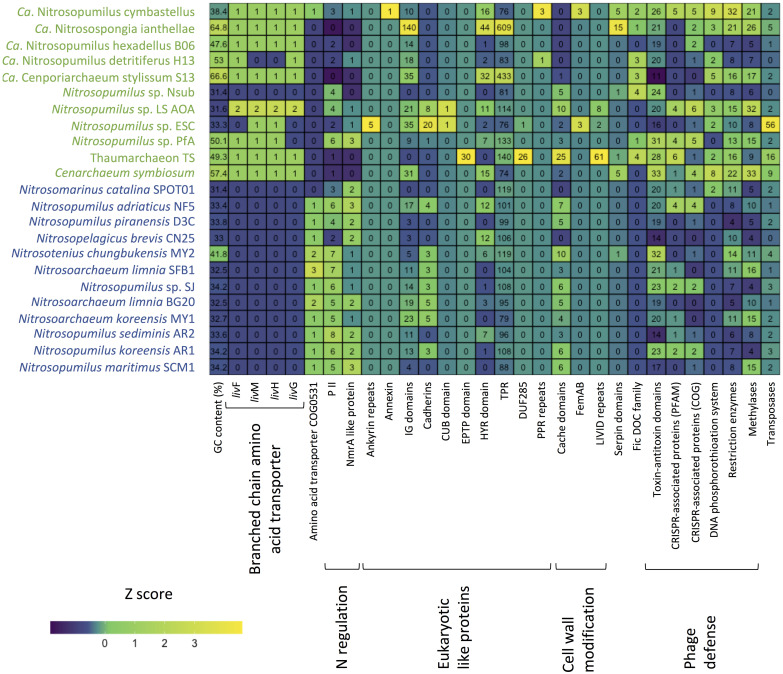
Heatmap summarizing functional differences in the genomic repertoire between sponge-associated (green) and free-living (blue) Thaumarchaeota. Numbers indicate copies per MAG.